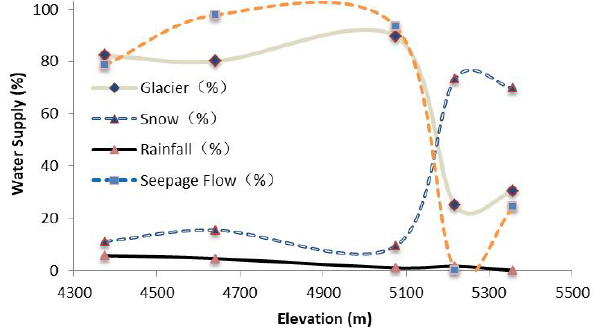
Figure 17. Water supplies to the lakes at different